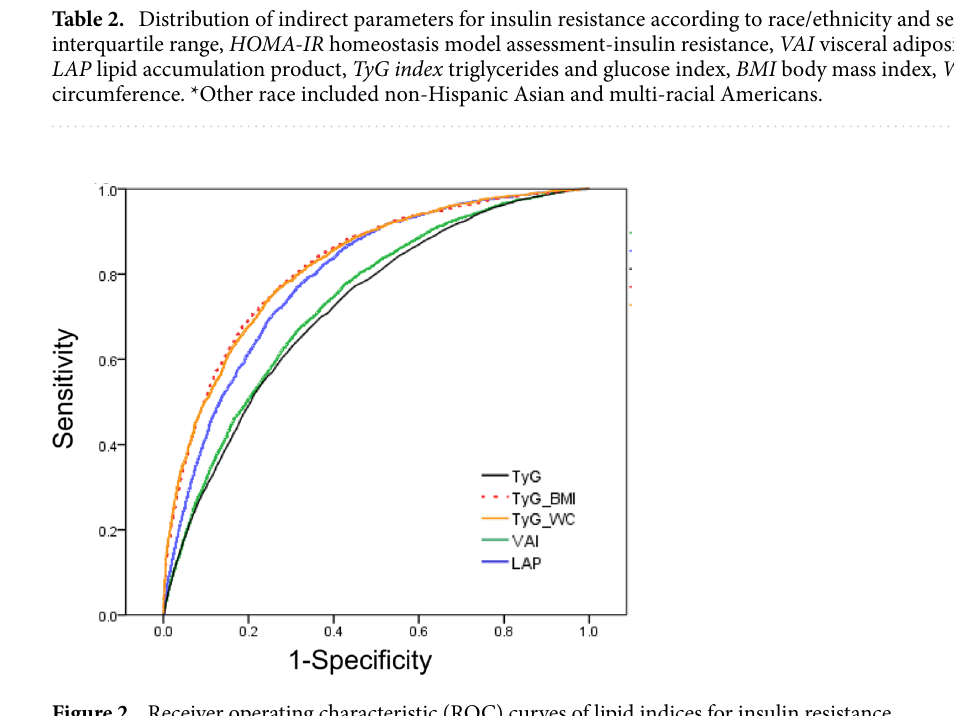
Figure 2. Receiver operating characteristic (ROC) curves of lipid indices for insulin